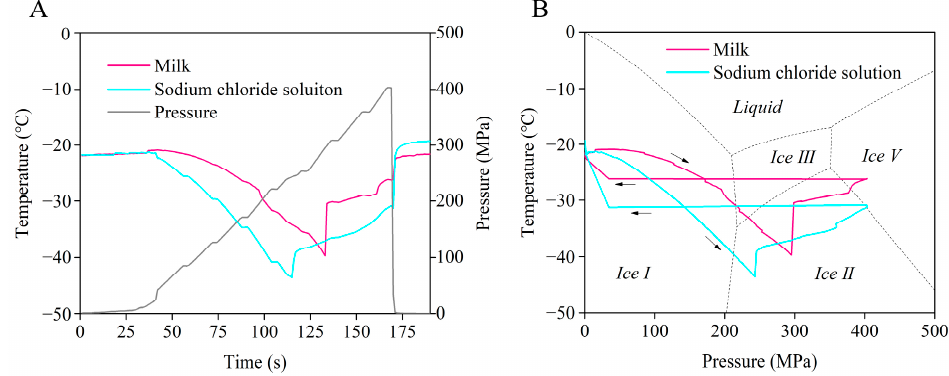
Figure 2. The temperature and pressure profiles of frozen milk during HP treatment: ( A ) temperature and pressure curves over time; ( B ) temperature–pressure profiles superimposed on the phase diagram of water. The black arrows indicate the direction in which the pressure increases and